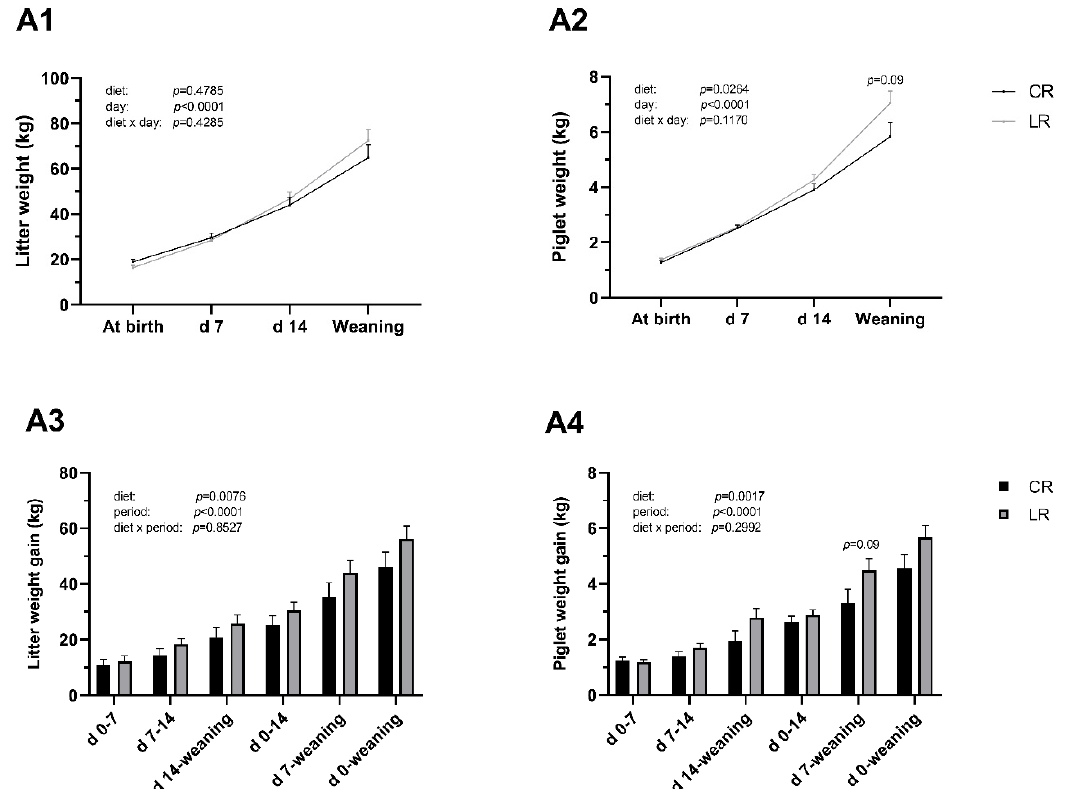
Figure 1. Low dietary ω 6: ω 3 ratio in sow improves body weight gain of neonatal piglets. Sows were fed diets with ω 6: ω 3 ratio = 13:1 during gestation, starting from day 28 (G28) and 10:1 during lactation (CR) or ω 6: ω 3 ratio = 4:1 from G28 until the end of lactation (LR). A1 : Litter weight development during neonatal period. A2 : Piglet weight development. A3 : Litter weight gain per subperiod. A4 : Piglet weight gain per subperiod. Data are LSM ± SE, n = 6 for CR group and n = 8 for LR